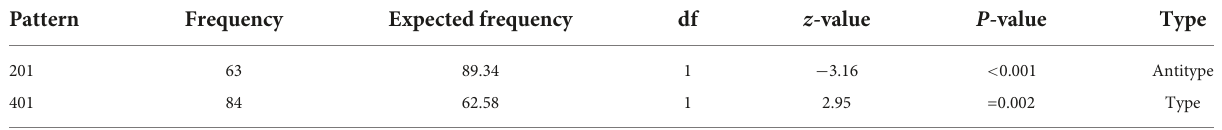
TABLE 5 Configural frequency analysis of drawing type and